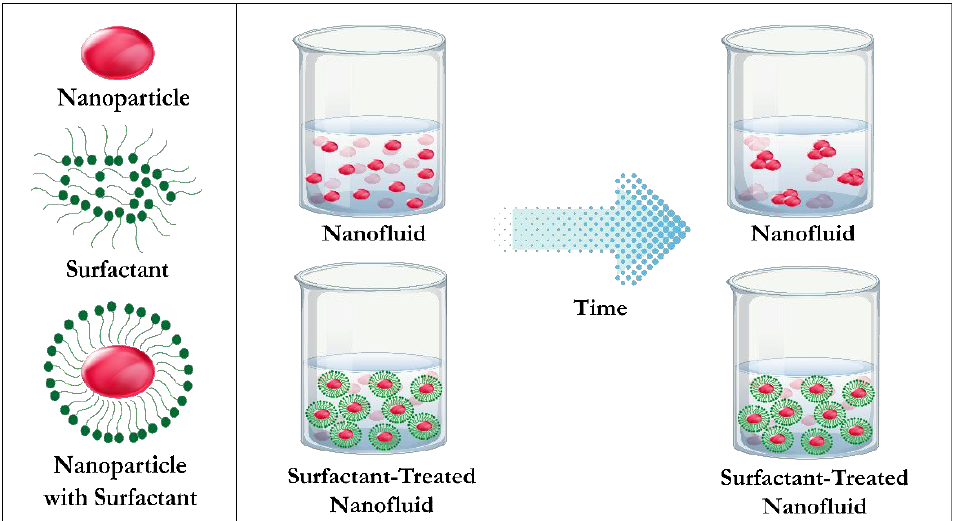
Figure 1. Stability of nanofluids in the presence of surfactants. The figure is not to scale and is just a representation. In the illustration nanoparticle refers to both individual NPs and NP clusters within the solution.